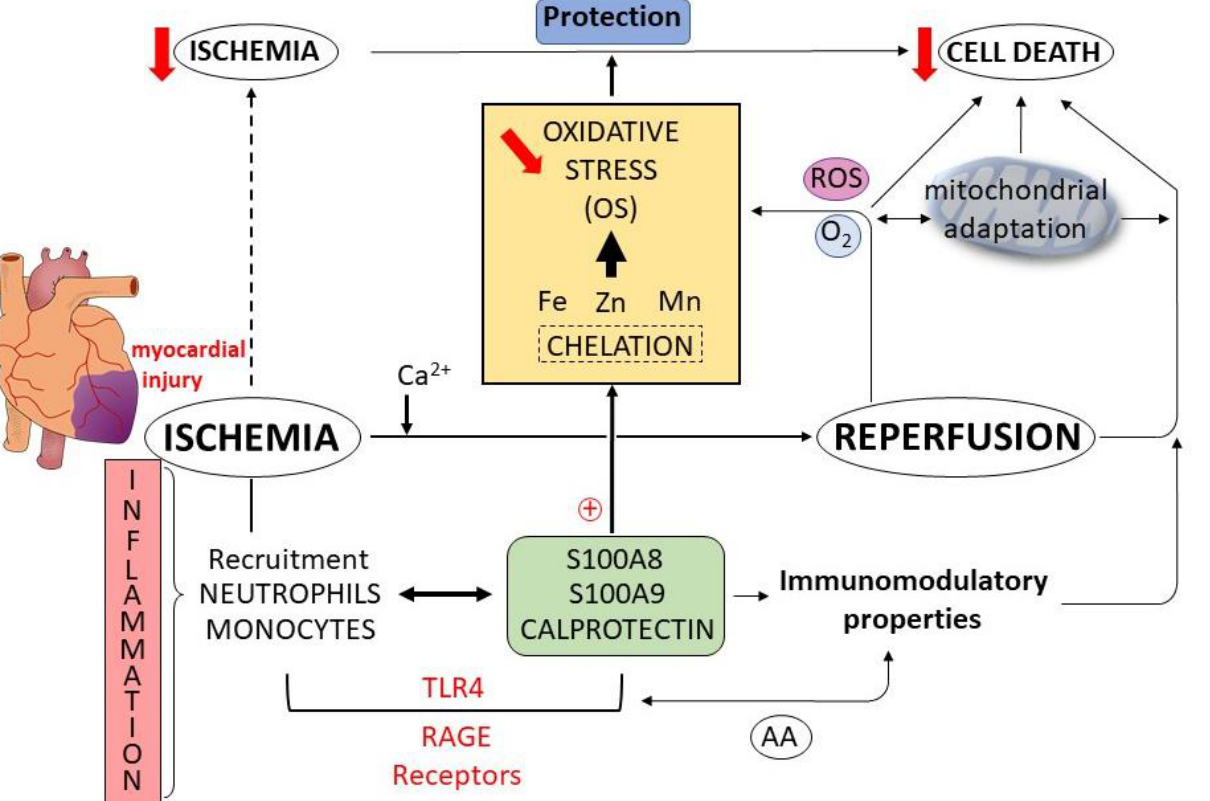
Figure 3. Schema showing the unifying mechanisms of cardioprotection induced by calprotectin (CLP) associated with oxidative stress (OS) modulation during ischemia–reperfusion sequence. This sequence induces inflammatory signaling, recruitment of neutrophils and monocytes associated with the potential development of cardiac dysfunction and cell death. Following myocardial ischemia injury, S100A8, S100A9 and CLP are expressed and secreted by inflammatory cells. S100 proteins and CLP bind to TLR-4 and RAGE receptors. Arachidonic acid (AA) possesses immunomodulatory properties, suppressing the expression of adhesion molecules on endothelial cells. CLP chelate transition metal ions (Fe, Zn, Mn) with strong affinity, leading to a reduction in OS, a mitochondrial adaptation and cardioprotection (reduction in ischemia). Red downward arrows: reduction of the process, red circled plus: positive activation of the